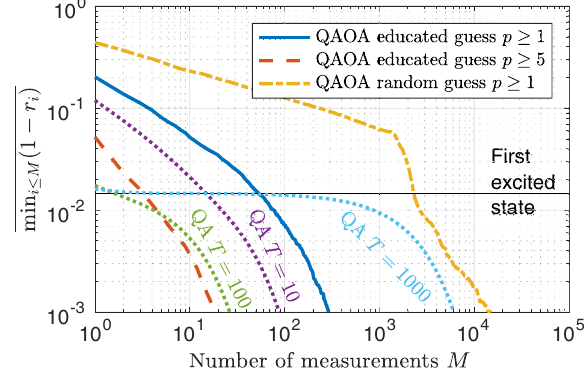
FIG. 7. Full Monte Carlo simulation of the QAOA accounting for measurement projection noise, on the example 14-vertex instance studied in Fig. 6(b). For various optimization strategies, we keep track of approximation ratio r i ¼ j Cut i j = j MaxCut j from the i th measurement and plot minimum fractional error 1 − r i found after M measurements, averaged over many Monte Carlo realizations. The blue solid and red dashed lines correspond to QAOA optimized with the FOURIER strategy starting with an ⃗ β educated guess of ð ⃗ γ ; Þ at p ¼ 1 and p ¼ 5 , respectively. The orange dash-dotted line corresponds to the QAOA optimized starting with random guesses at p ¼ 1 . The three labeled dotted lines are results from QA with total time T ¼ 10 , 10 2 , 10 3